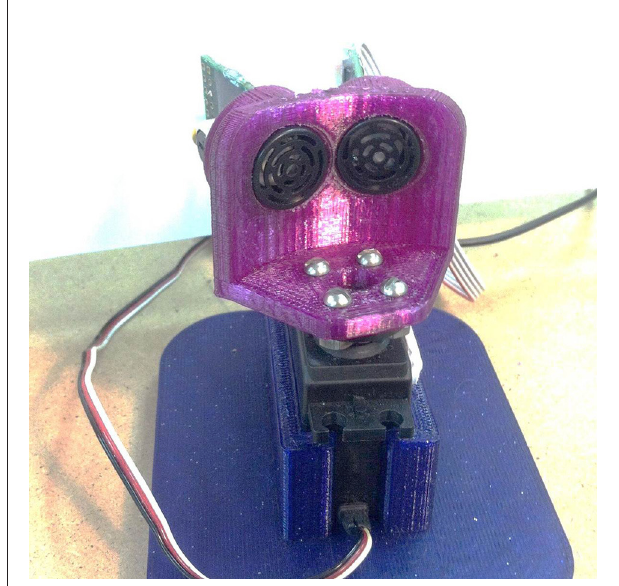
FIGURE 1 | The A two transducer sonar head mounted on a hobby servomechanism that was used for the experiments in this paper. The sonar modules are a custom 40kHz system modified from a high-power Maxbotix